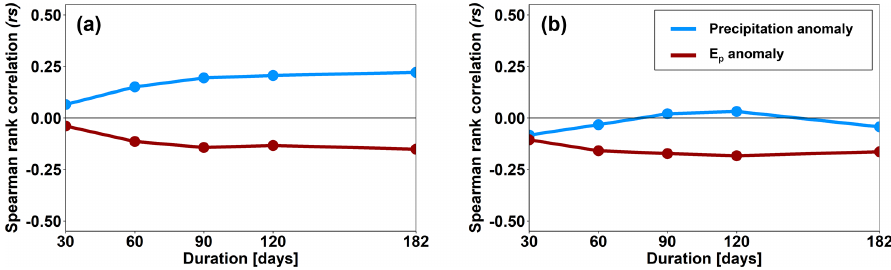
Figure 6. Spearman rank correlation coefficients between precipitation (blue) and E p anomalies (red) and Q min of warm-season (May to November) low flows for durations of 30 to 182d across all stations and years. The overall explanatory power of the climate anomalies in a bivariate regression framework is low, although precipitation anomalies are slightly better correlated to Q min than E p anomalies in the whole data set (a) . In the 4 driest years (b) , the overall explanatory power of precipitation anomalies is much smaller, and the explanatory power of E p anomalies is slightly greater than in all years combined.